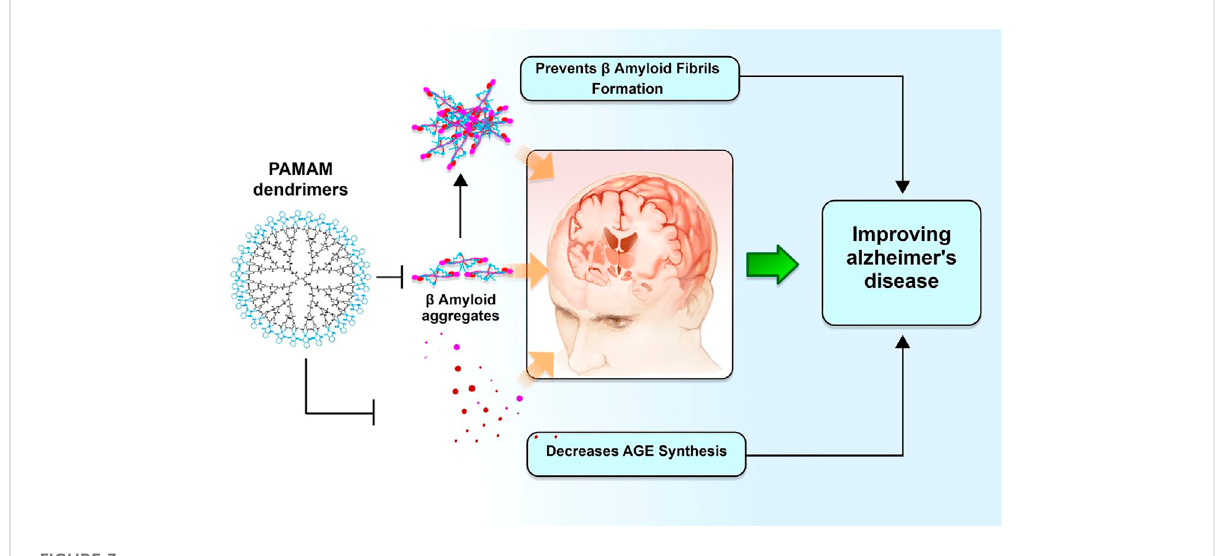
FIGURE 3 Dendrimers and their potential role in improving AD pathogenesis. Polyamidoamine dimers, also known as PAMAM, serve as modulators for amyloid fi brillar production. This, in turn, enhances biocompatibility and degradation of synapses against A oligomers, hence preventing a deterioration in memory associated with Alzheimer ’ s